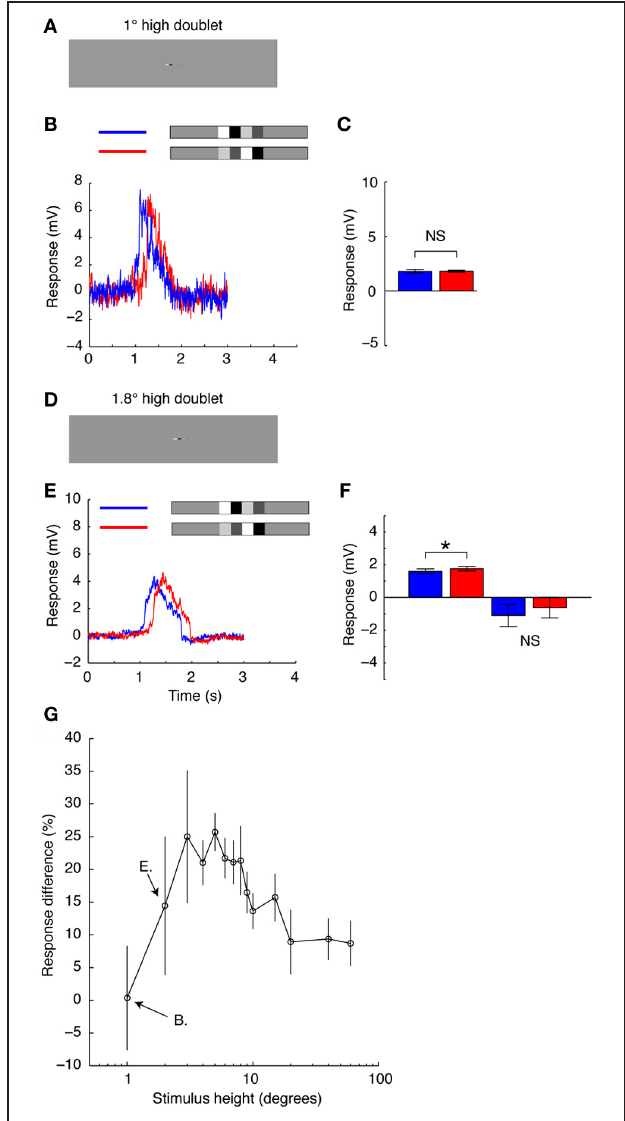
FIGURE 7 | The vertical extent of a small stimulus. (A) The doublet pairs presented using the whole-screen mode. The doublet pair has the same width as before, but is now only 1 ◦ high, just below the size of an individual ommatidium. (B) Intracellular HS neuron response to the doublet pair shown in A , as it passes through the receptive field in the preferred direction (blue = decreasing contrast, red = increasing contrast). (C) The mean response to the doublets as shown in part B. N = 1, n = 9 ( t -test done across repetitions in the single neuron, errorbar calculated across n ). NS, no significant difference (Student’s t -test). (D) The doublet is now 1.8 ◦ high. (E) Intracellular HS neuron response to the doublets as they pass through the receptive field in the preferred direction. (F) The mean response to the doublets moving in the preferred and anti-preferred direction. N pref = 4, n = 135. N null = 1, n = 20 ( t -test done across repetitions in the single neuron, errorbar calculated across n ). ∗ Indicates a significant difference ( p < 0 . 05, Student’s t -test). NS, no significant difference (Student’s t -test). (G) The average response difference between the increasing and decreasing contrast pairs as a function of their vertical extent. A positive difference indicates that the response to the increasing contrast ensemble is larger. N = 1, n = 8 (errorbars calculated across n